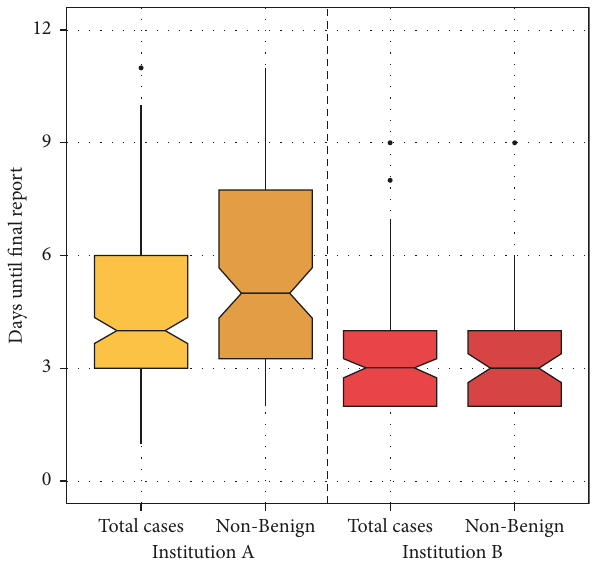
Figure 2: Days until final